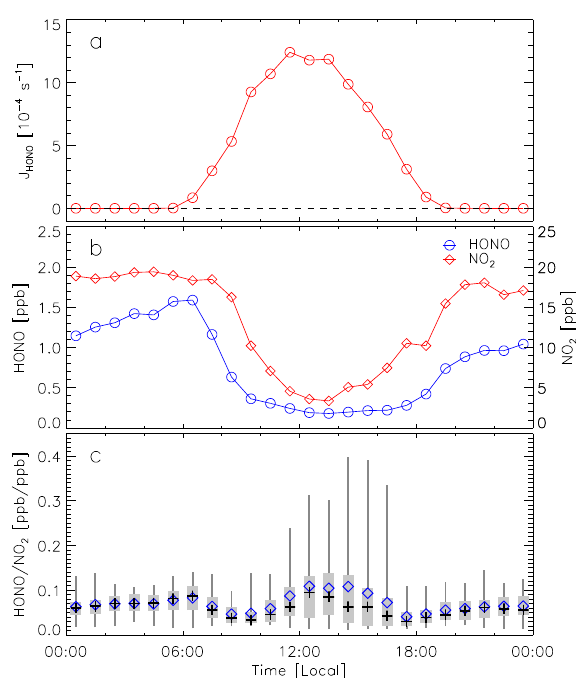
Fig. 3. Mean diurnal cycle of J HONO , HONO, NO 2 and HONO / NO 2 at the Back Garden supersite in July 2006. In (c) , the + refers to the median, boxes represent 50% (25% to 75%), the whiskers 90% of the data. The blue diamond is the